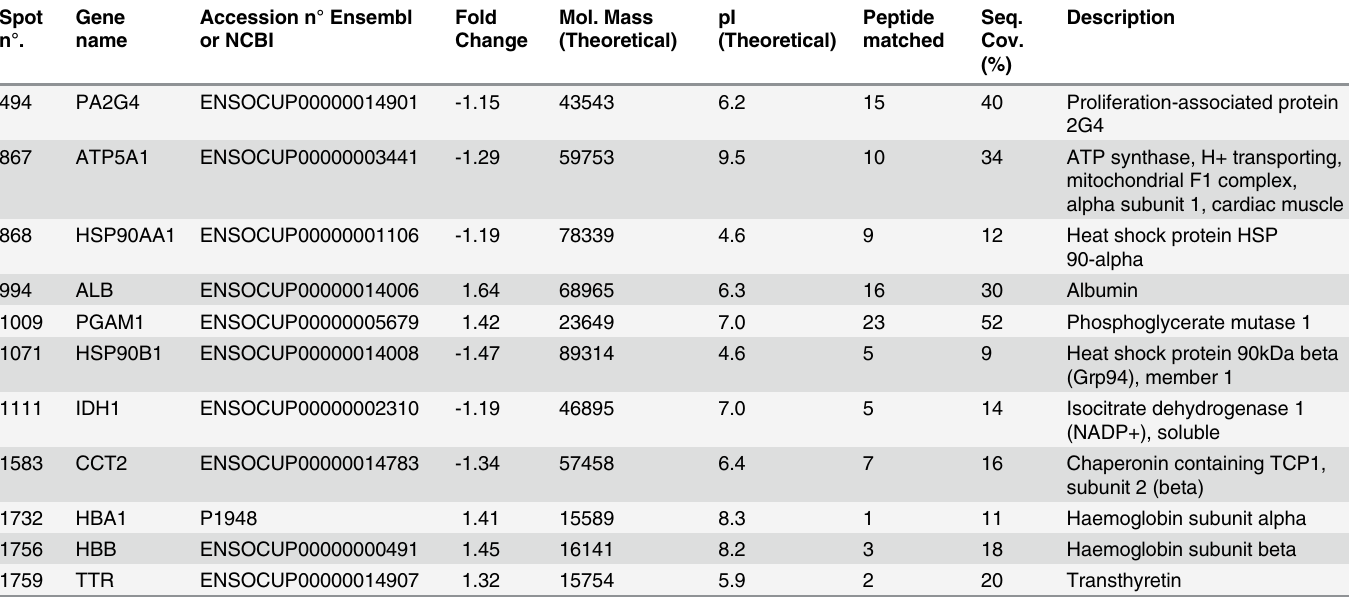
Table 2. List of identified altered proteins at Day 14 of gestation. Spot